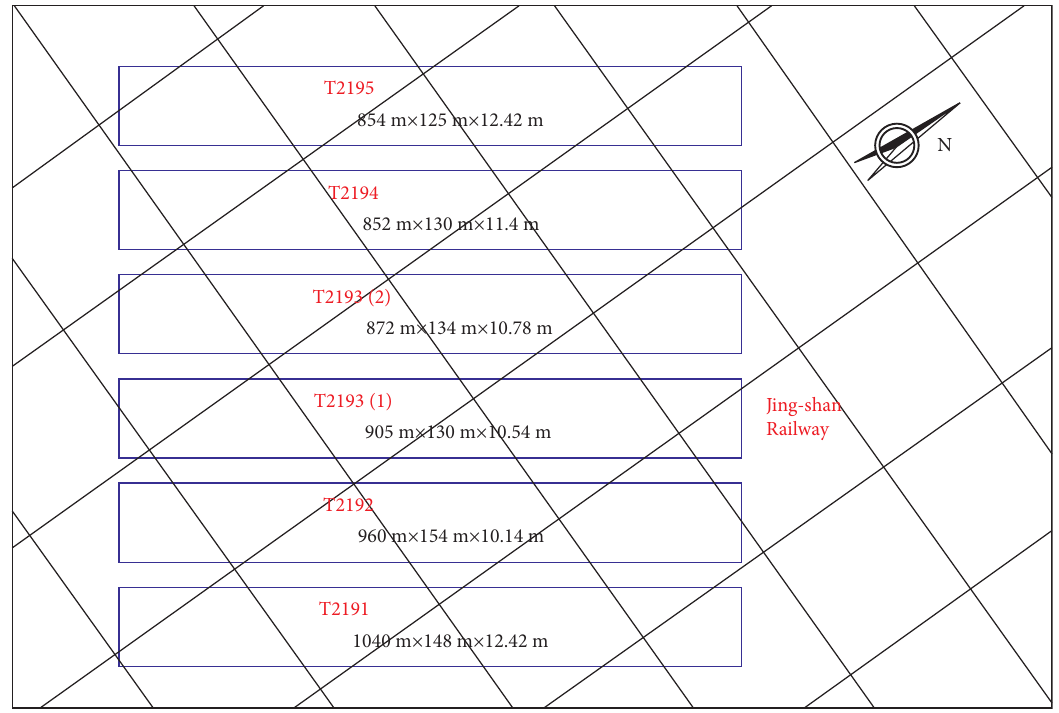
Figure 1: Distribution of six working mining faces in the Tier 2